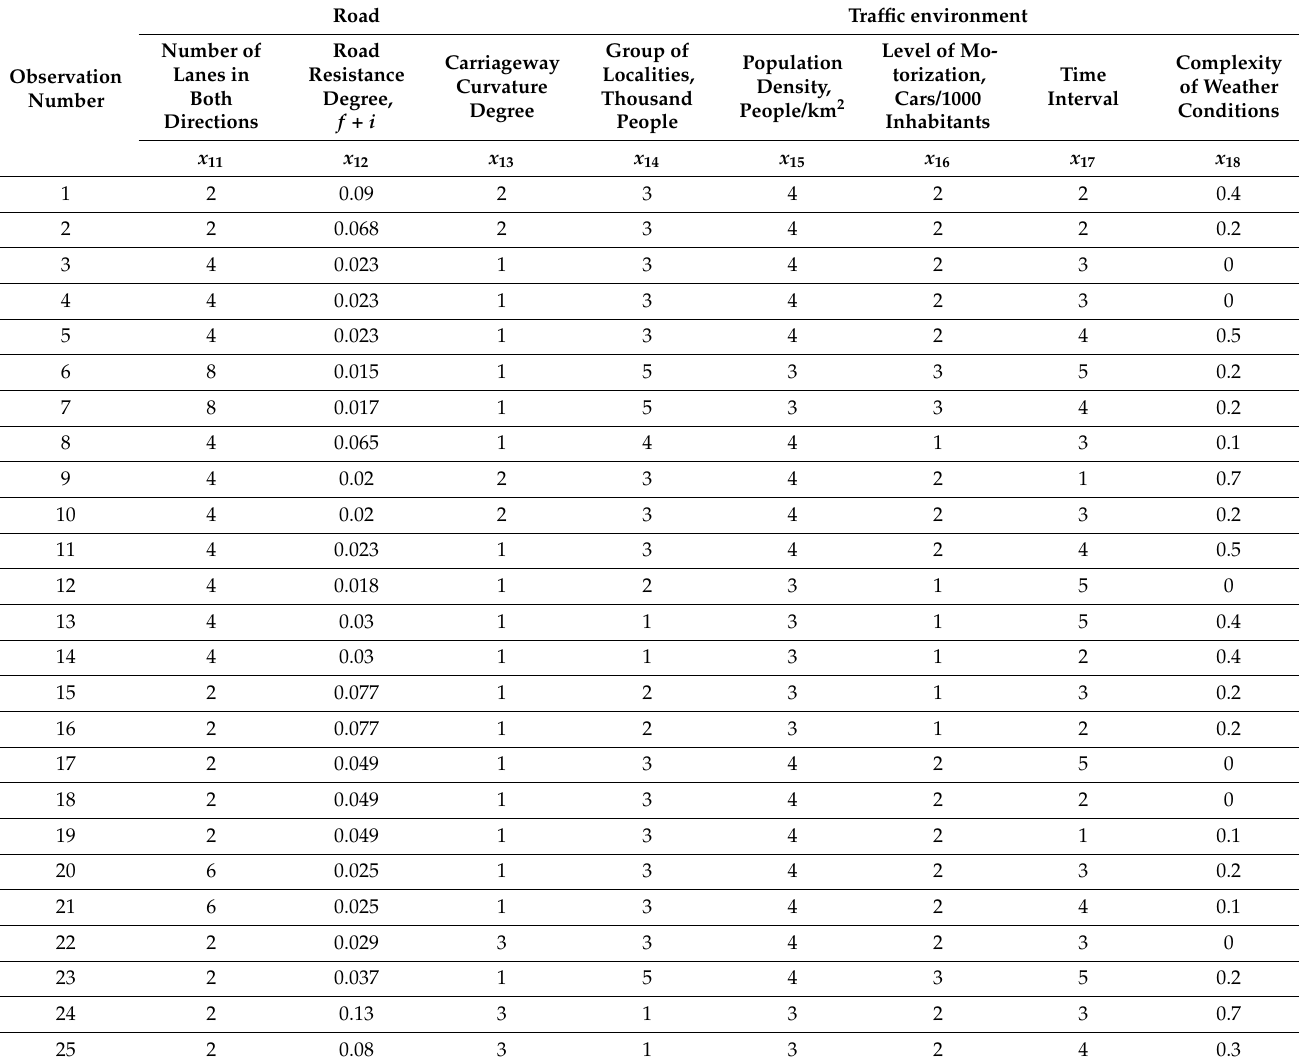
Table 5. Observation results for the functional elements “Road” and “Traffic